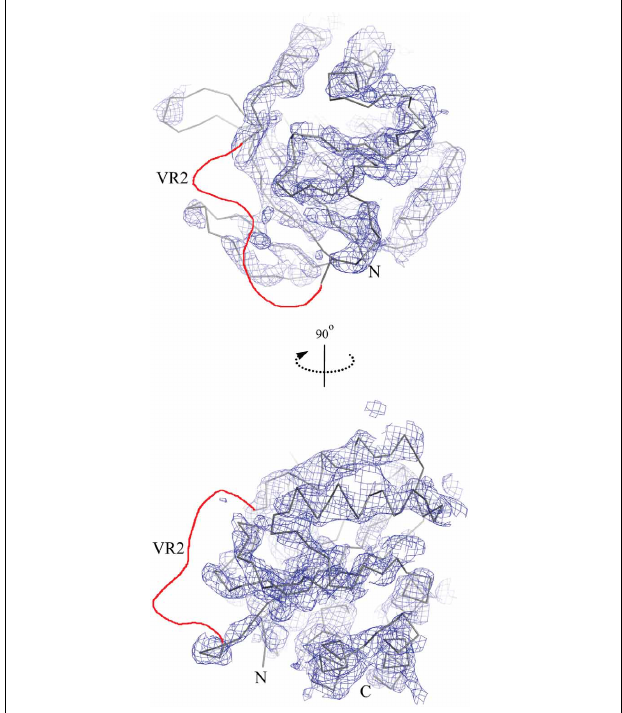
FIGURE 2 | The low resolution crystal structure of the cytoplasmic N-terminal NCBE core domain. The lines show a C- α trace of the molecular replacement model structure Nt-AE1 [1HYN, (Zhang et al., 2000)] and the chicken wire shows the corresponding electron density contoured at 1.5 σ . Only density for constant regions 1 and 2 (D118-H222 and K293-F389) is visible. No density was observed for variable region 2 (H223-K292) in the structure. The likely position of VR2 is shown as a red line in the figure. Other regions not visible in the electron density were residue ranges 96–117 and